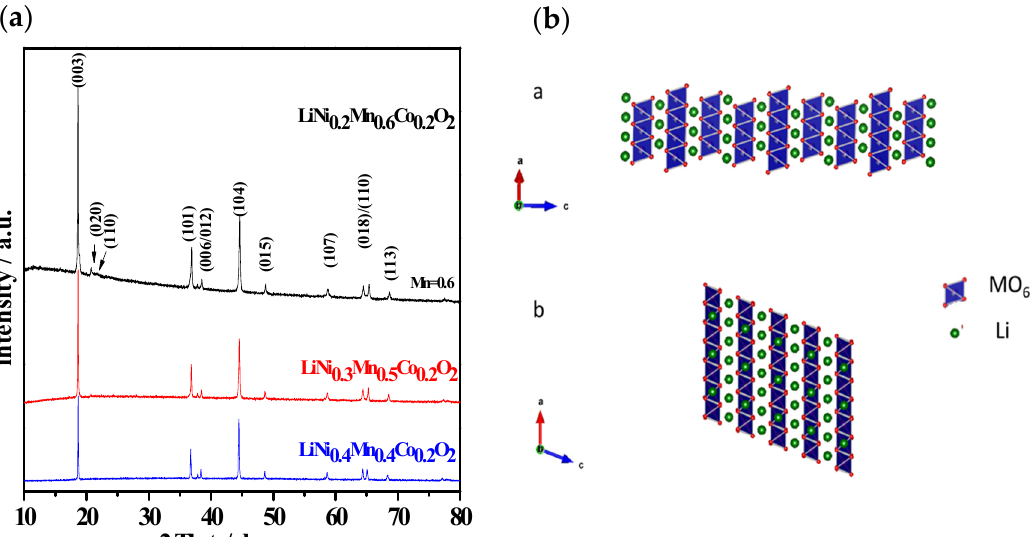
Figure 1. ( a ) X-ray diffraction patterns that correspond to NMC with different Mn ratios, ( b ) (a) integrated layered rhombohedral structure of the LiNi0.2Mn0.6Co0.2O2 cathode, and ( b ) (b) layered monoclinic phase that contains Li in the M-layer, which induces cation ordering in the structure (M-layer is the transition metal layer, comprising of Ni, Co and Mn).